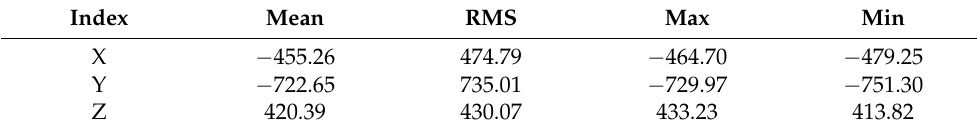
Table 1. Initial positioning accuracy of ZY-3 three-line array camera. (Unit: meter).